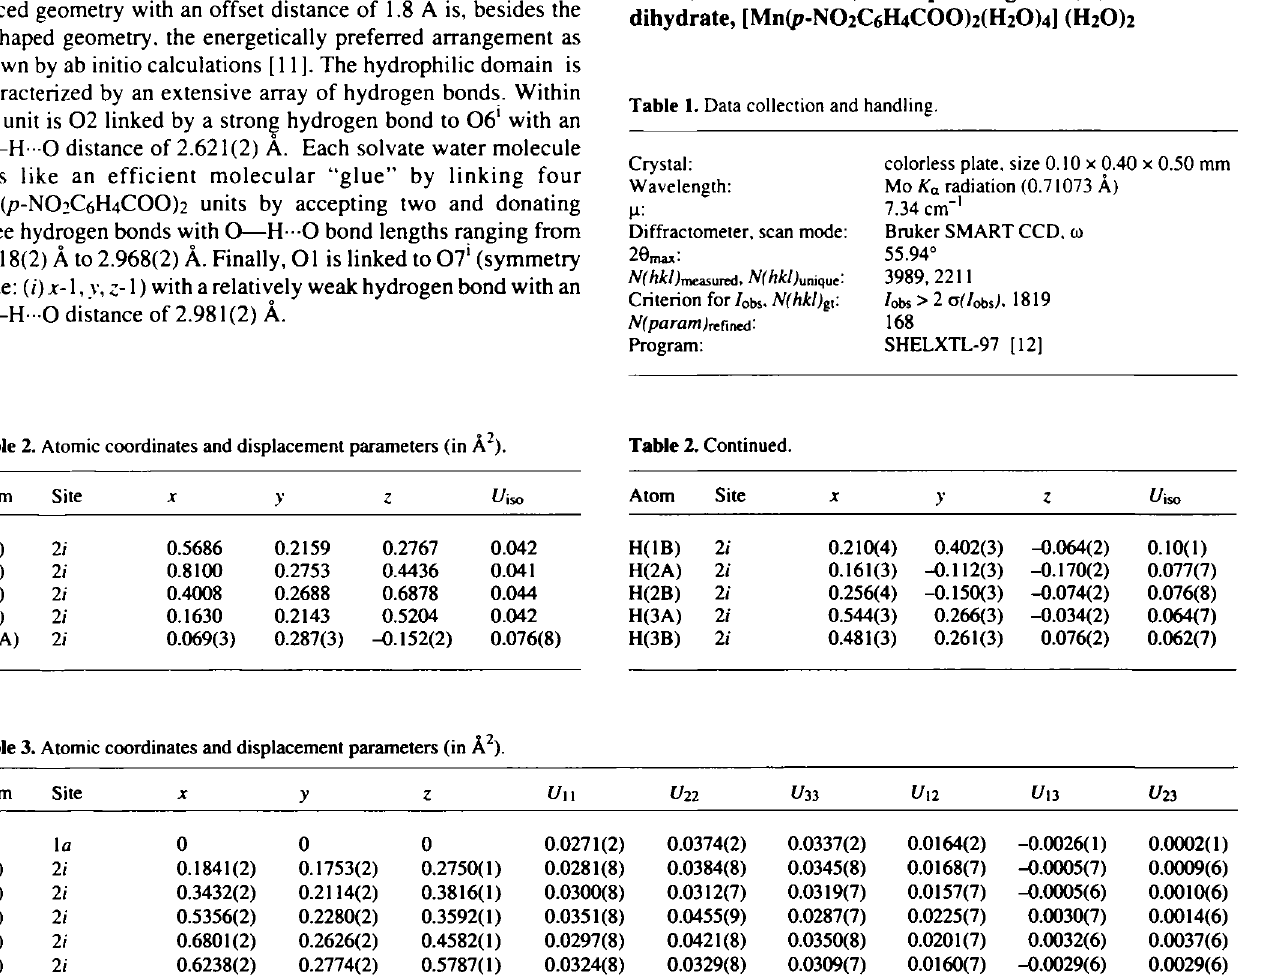
Table 3. Atomic coordinates and displacement parameters (in Ä 2 ).